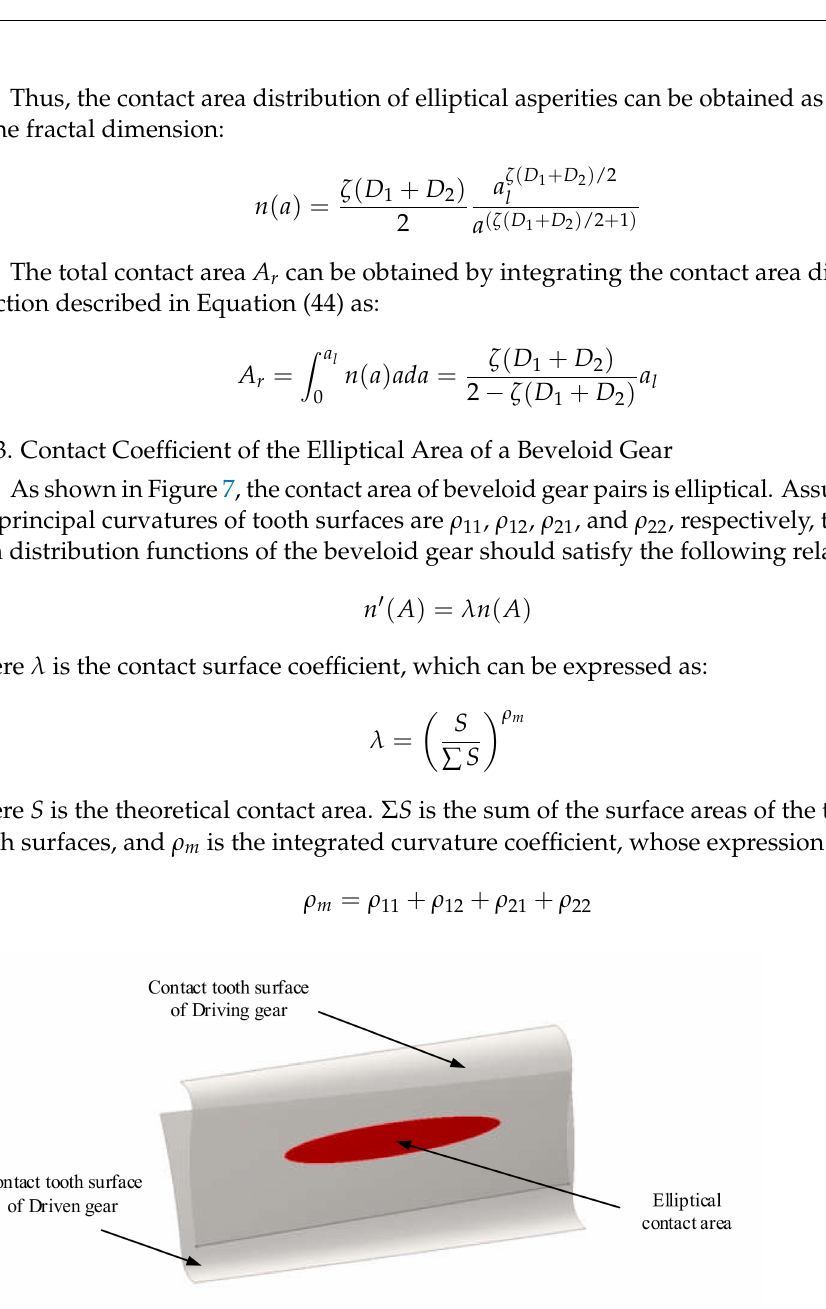
Figure 7. Schematic diagram of a beveloid gear with the crossed